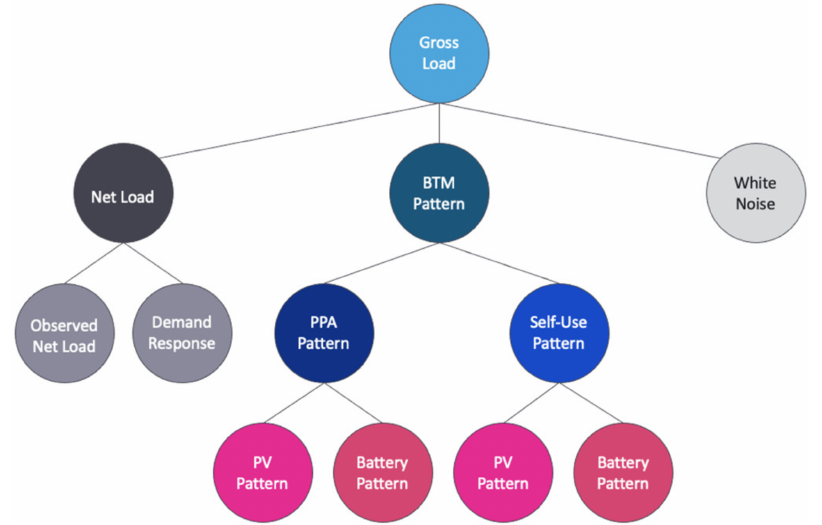
Figure 1. Hierarchical relationships between distributed energy resources including net loads and hidden